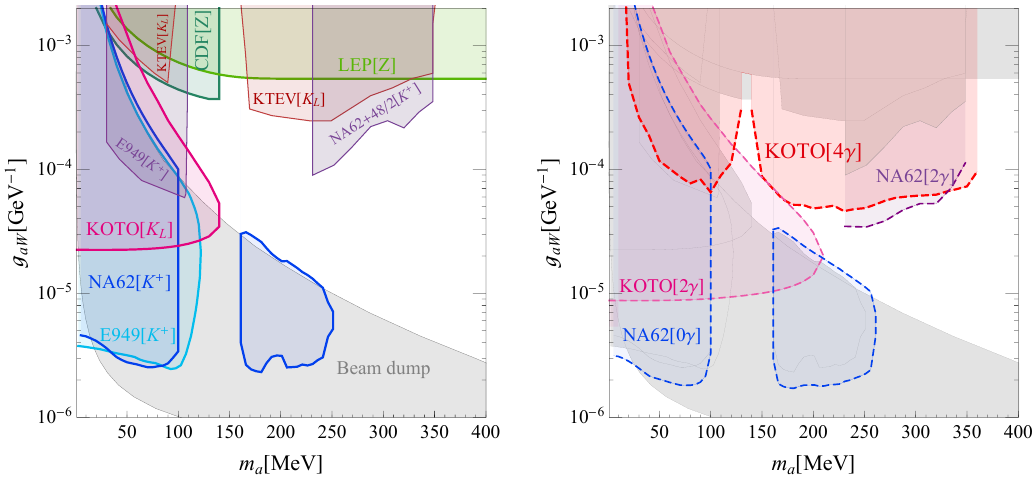
Figure 9 . Left panel: present bounds on the parameter space of the SU(2) coupled-ALPs, as a function of the ALP mass, m a , and of its couplings with SU(2) gauge bosons, g aW . Right panel: present and future bounds on the parameter space. In gray, we present the present bound (as shown in the left panel); in red and magenta, and in purple and blue, we present the future bounds at KOTO (4 (cid:13) and 2 (cid:13) + invisible signatures), and at NA62 ( (cid:25) + + 2 (cid:13) and (cid:25) + + invisible